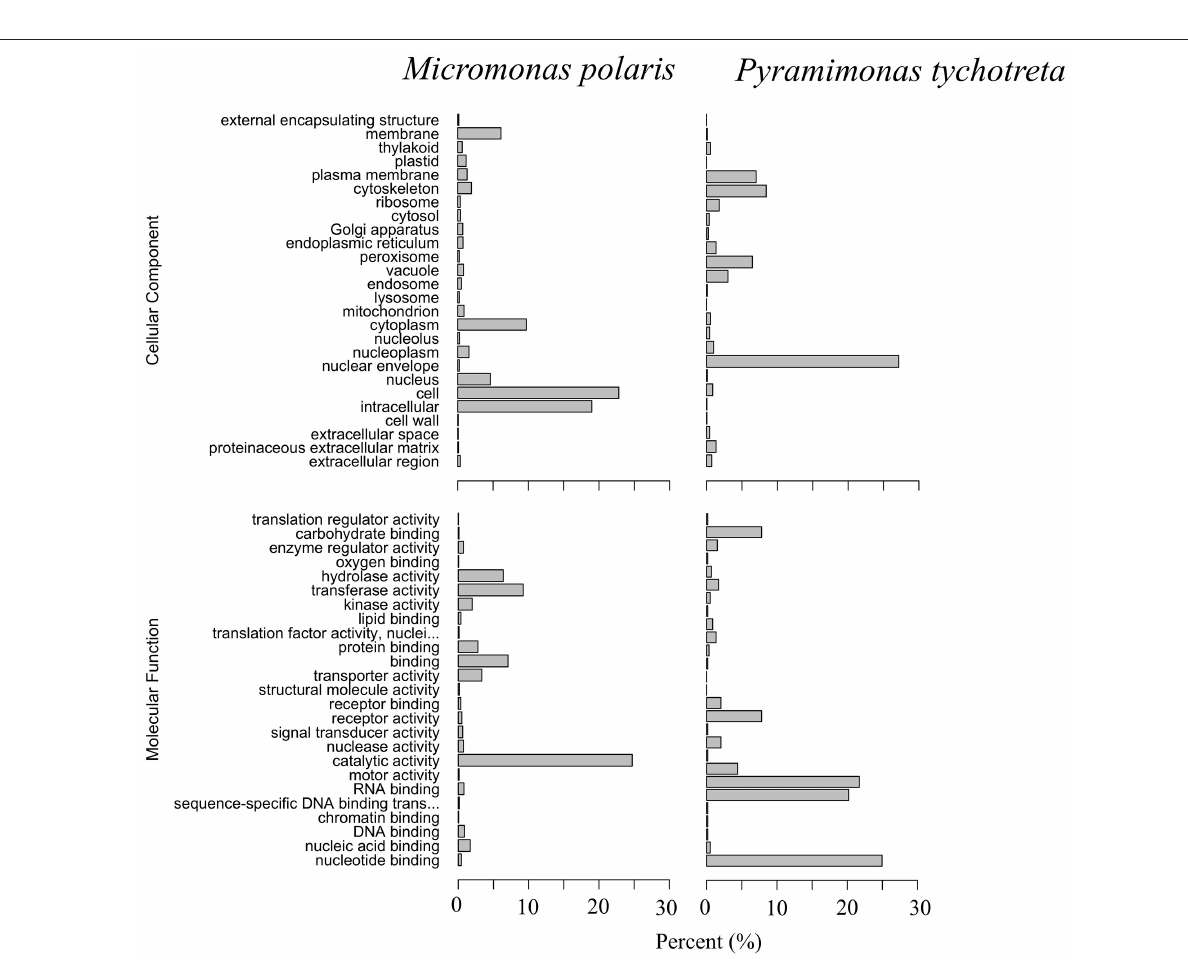
Frontiers in Marine Science | www.frontiersin.org